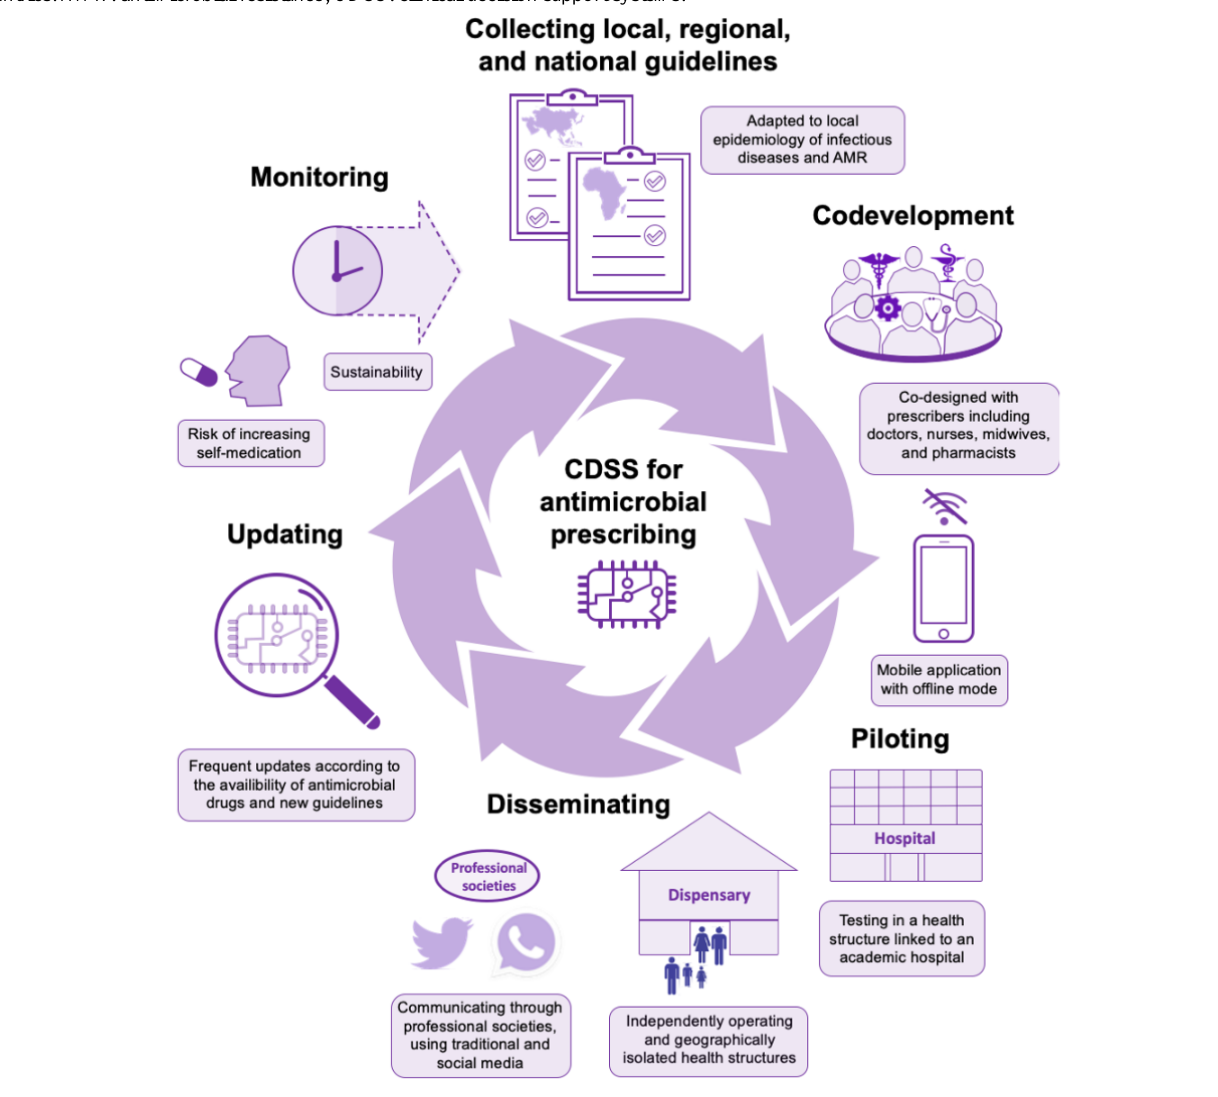
Figure 3. Key steps for the development and implementation of a clinical decision support systems for antibiotic prescription in low- and middle-income countries. AMR: antimicrobial resistance; CDSS: clinical decision support